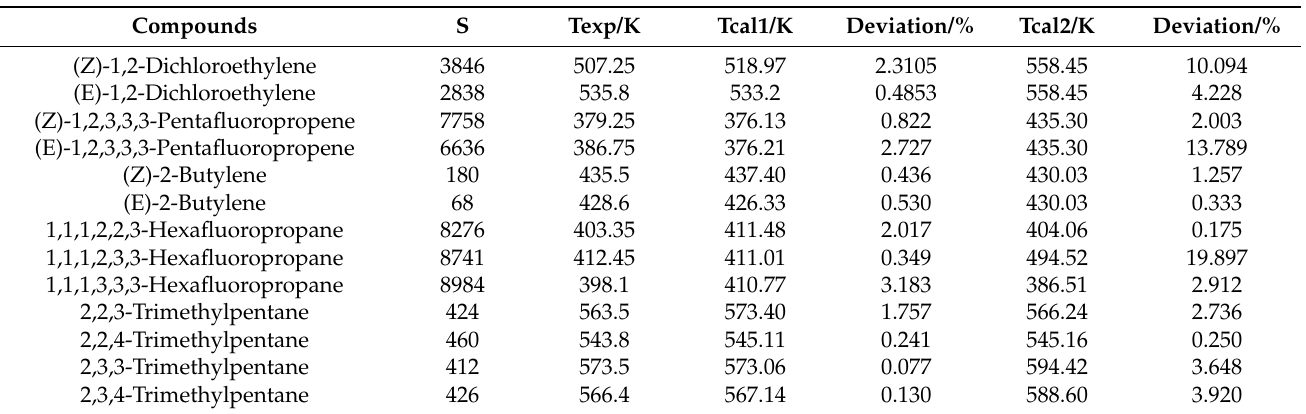
Table 2. Prediction samples of isomers in pure working